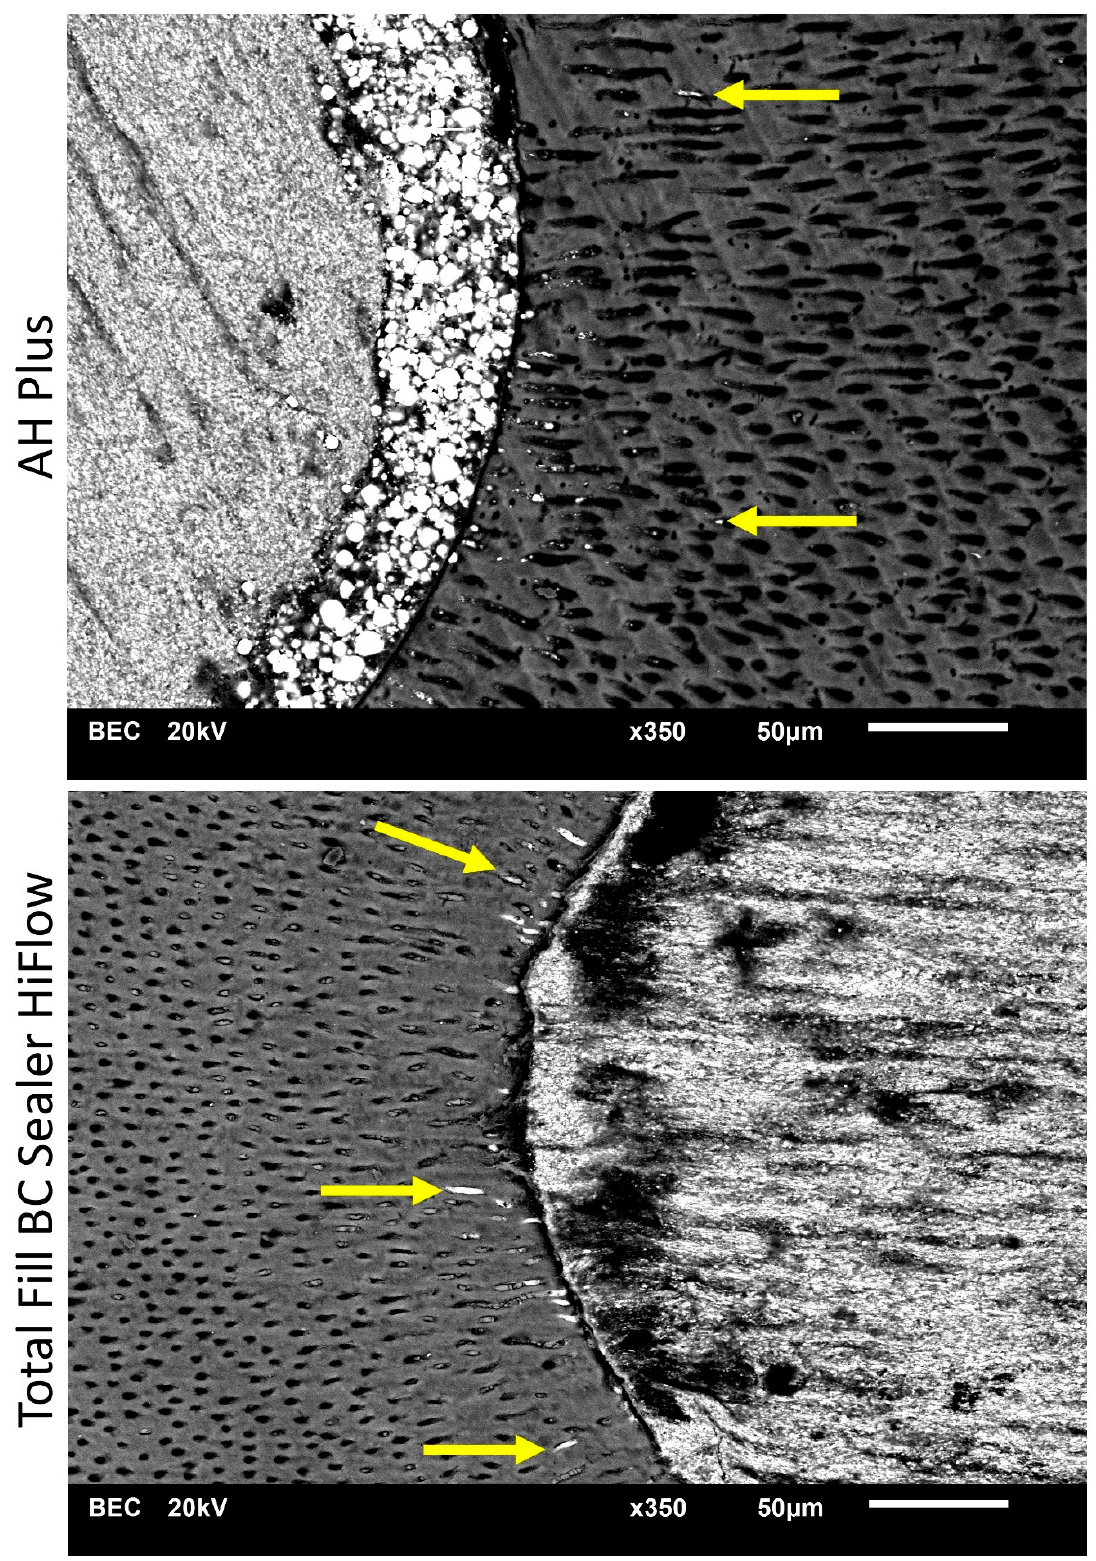
Figure 1. Scanning electron microscope (SEM) images display sealer penetration depth of AH Plus and Total Fill BC Sealer HiFlow after warm vertical root canal obturation at 2 mm from the root apex. Arrows indicating the sealer penetration depth found in SEM images.